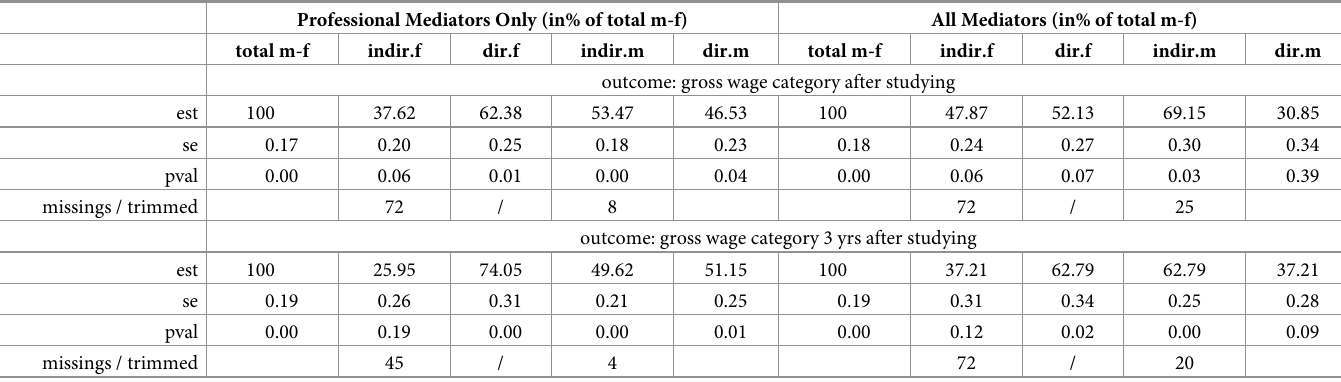
Table 9. Disentangling the contributions of professional and personal mediators in percent of the total effect (trimming equal to 0.02).